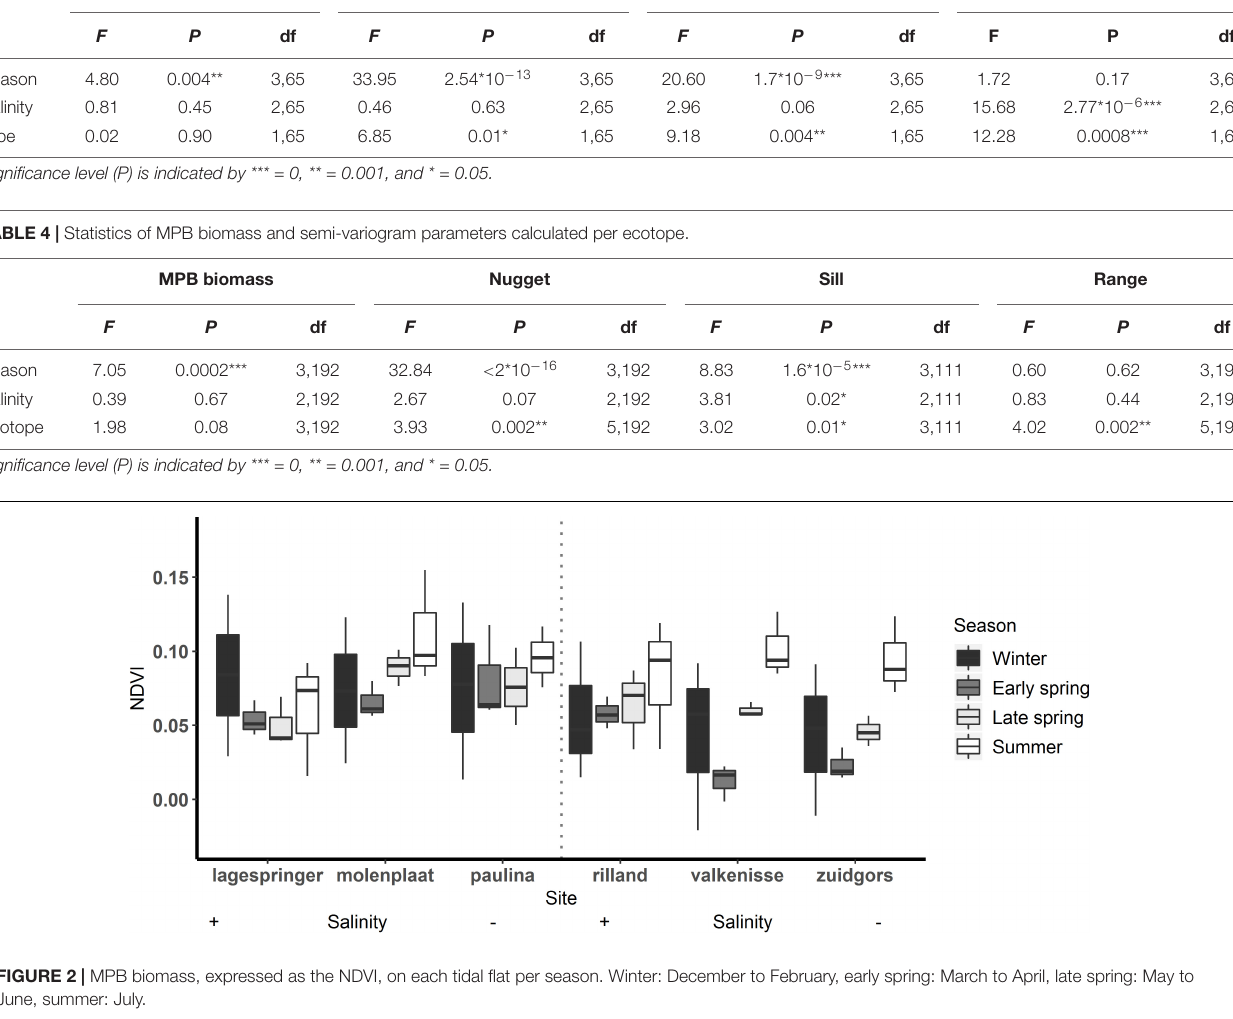
mesohaline zone (603 m) than in the weakly polyhaline (338 m) and strongly polyhaline zone (366 m) (ANOVA, P = 2.77 ∗ 10 − 6 , F 2 , 65 = 15.68, n = 72; HSD Tukey, p < 0.0001). Furthermore, the range was higher at tidal flats located in the mid-channel (510 m) than at fringing tidal flats (362 m) (ANOVA, P < 0.001,